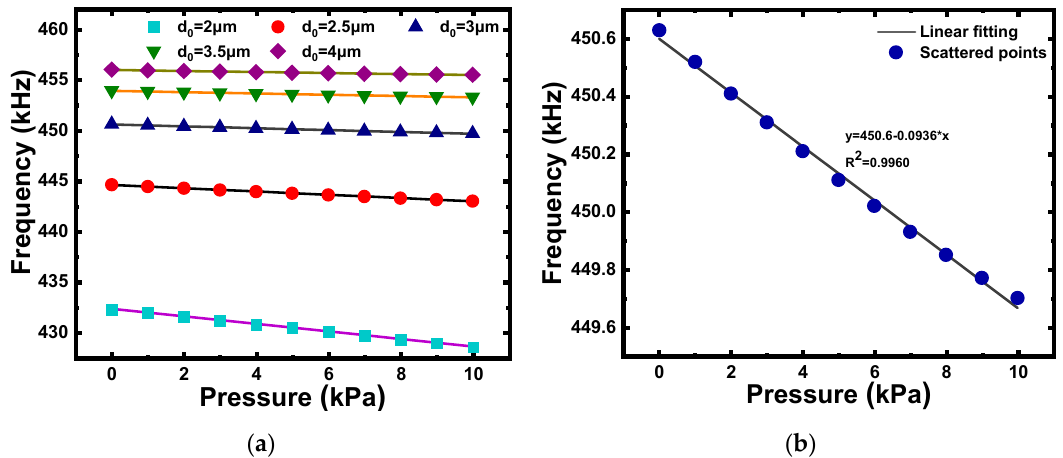
Figure 4. ( a ) Resonance frequency of C1 with different cavity heights of 2 μm , 2.5 μm , 3 μm , 3.5 μm , and 4 μm for pressure detection in the range of 0–10 kPa. ( b ) Resonance frequency of C1 with different cavity heights of 3 μm for pressure detection in the range of 0–10 kPa.